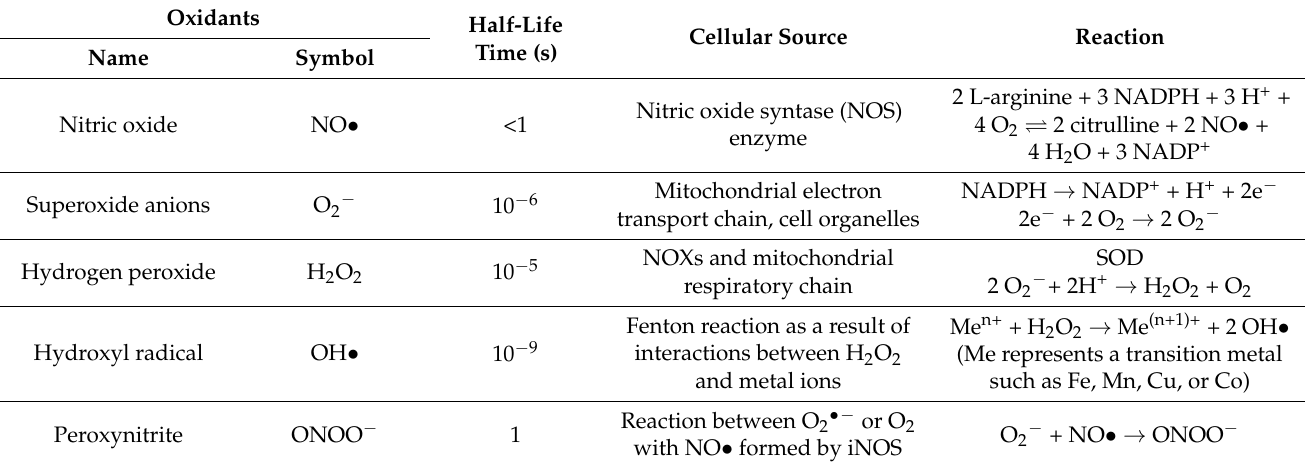
Table 1. List of oxidants that are relevant in biology, as well as the reactions and cellular effects.